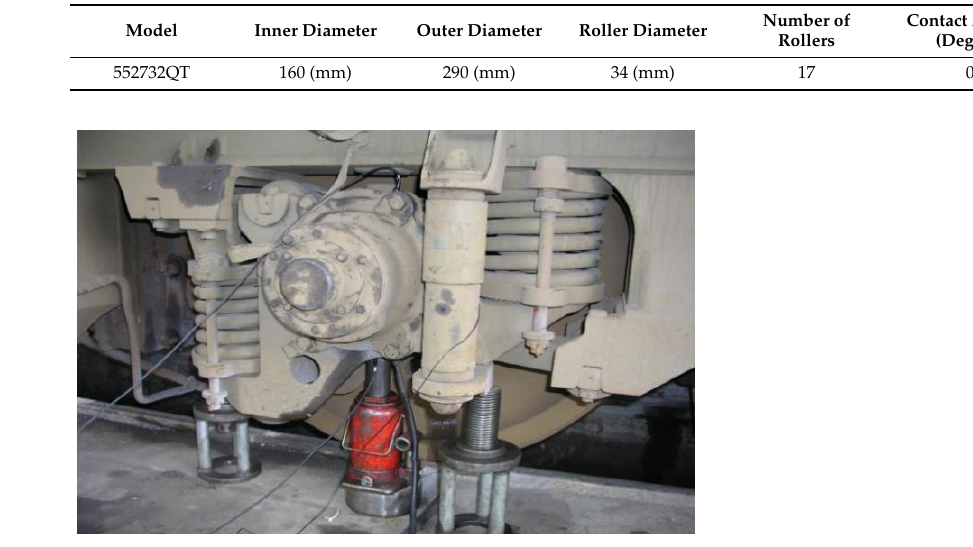
Figure 14. Locomotive rolling bearing top wheel test device.